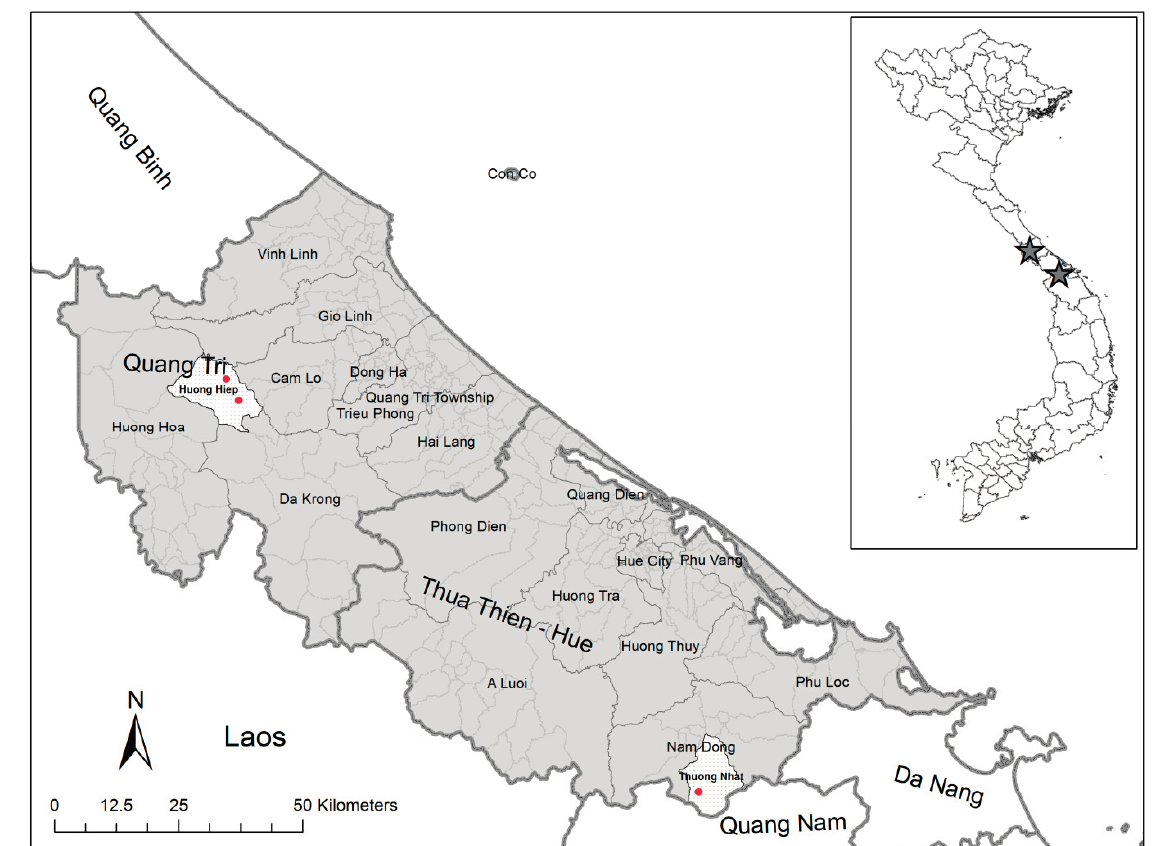
Figure 2. Map of the research areas.